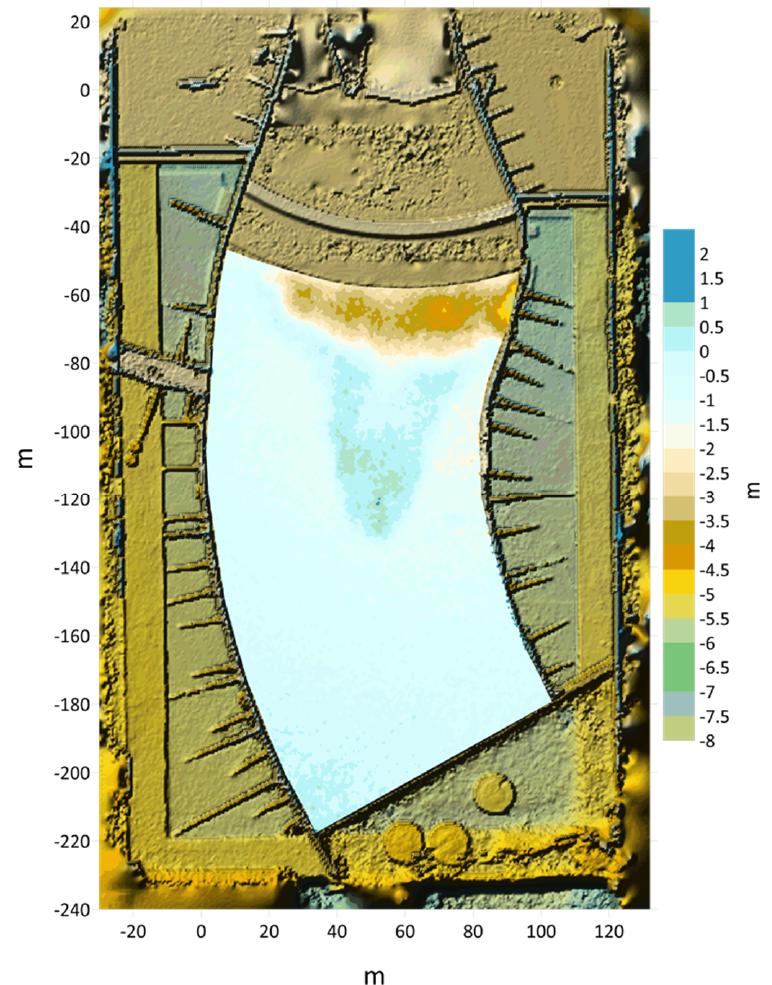
Figure 10 . Erosion/deposition map (dimensions in meters) reconstructed processing images of Test #1; the discharge is equal to 830 m 3 /s (same as in the event of January 2003). The ski jump sill is in place during the experiment.